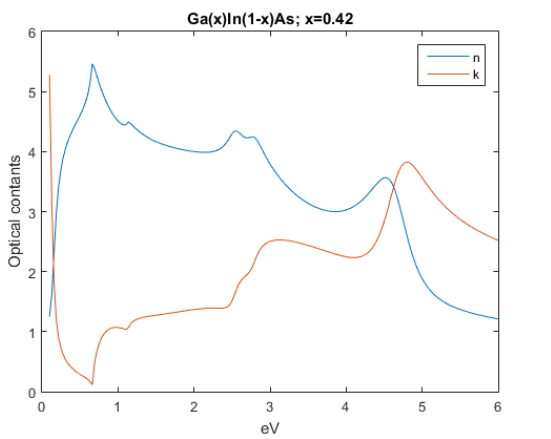
Figure 8. Real and imaginary optical constants of Ga 0.42 In 0.58 As